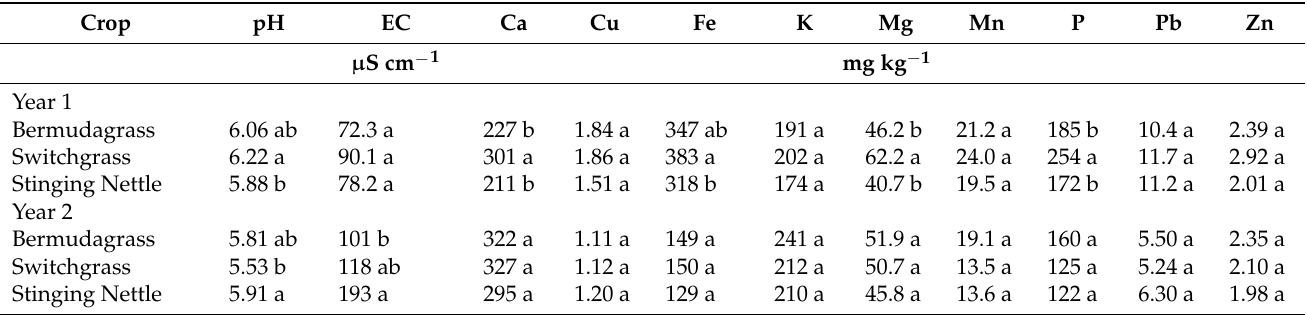
Table 7. Soil pH, EC, nutrient and metals from forage plots for the first and second